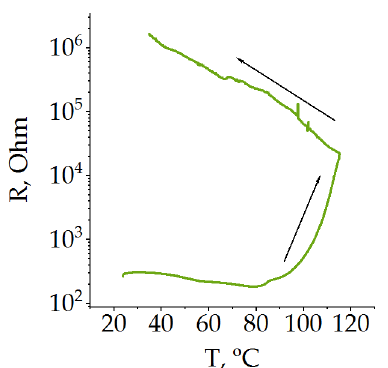
Figure 1. Poly[Ni(CH 3 OSalen)]structure ( a ) and resistance of the poly[Ni(CH 3 OSalen)] layer in 1 M LiPF 6 EC/DEC electrolyte, according to the data of [46] ( b ).